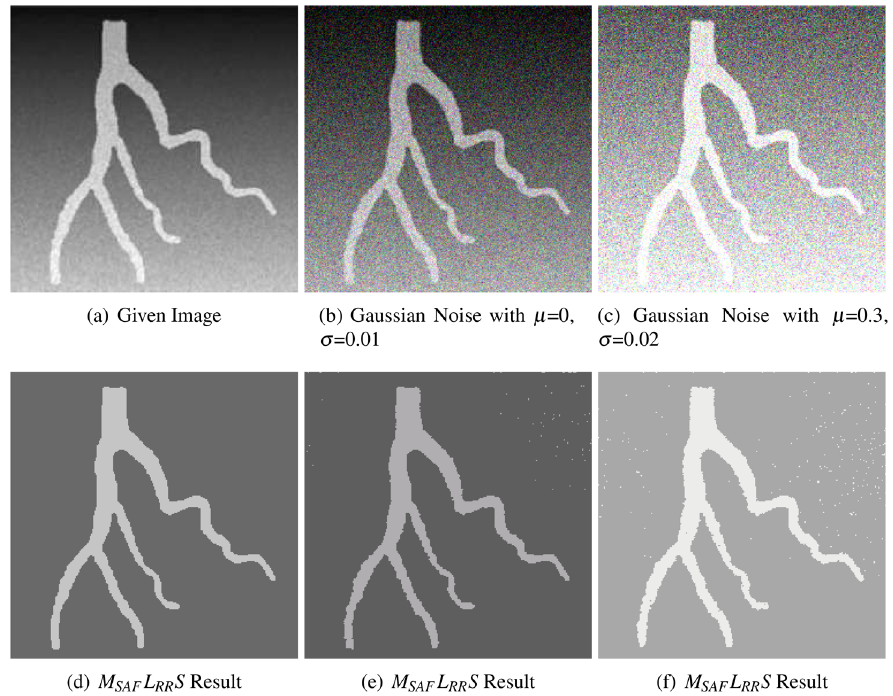
Figure 4. This figure demonstrates the performance of the suggested approach M SAF L RR S on a slight intensity inhomogeneous image in which Gaussian noise is added and increased gradually from left towards right and top towards bottom. The first row represents all those given images that suffered from intensity inhomogeneity and noise while the second row represents the corresponding segmented outcomes of the proposed model. The images were taken from the kaggle repository 33 and the parameters which were used are (cid:31) 2 = 20 and k = 32 (scale